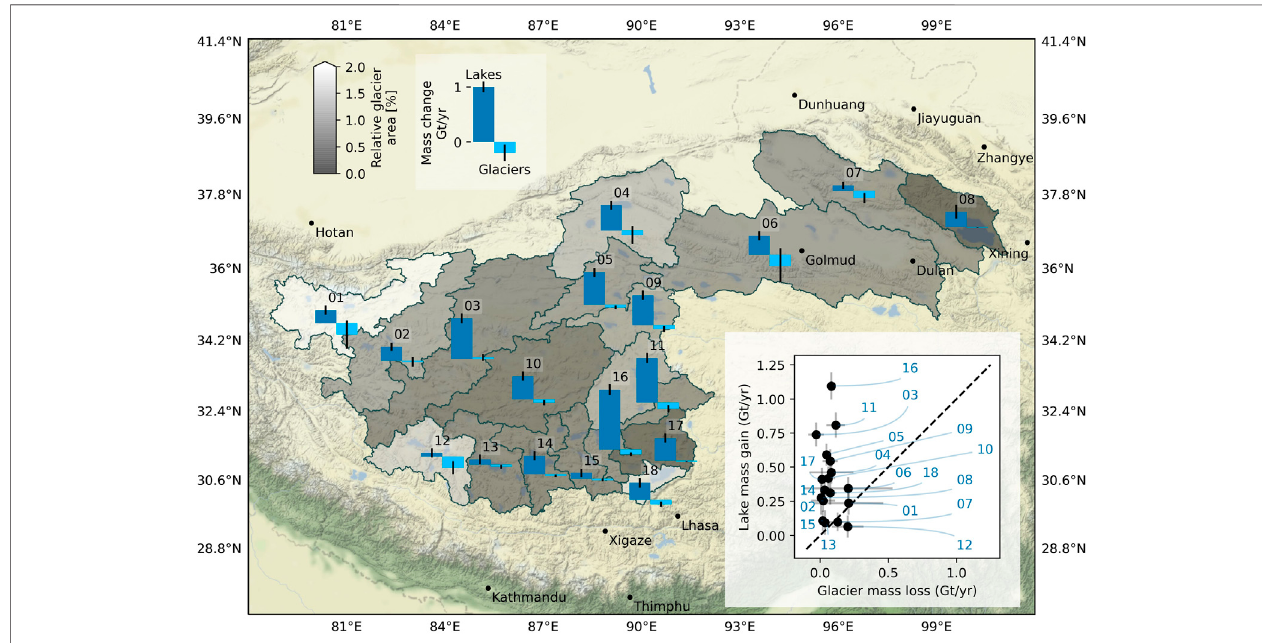
FIGURE1| Lakeandglaciermasschangeforthe18endorheicbasinsconsideredinthisstudy.Thebluebarsrepresentthetotalmasschangesandtheblacklines represent uncertainties, with all bars plotted using the same scale. The basins are shaded according to the ratio between the glacier area and the basin area. The basemap is aterrain layerfrom Stamen (http://maps.stamen.com).The insetshows thelake mass gainas afunction ofthe glacier mass loss for each basin (black dots), with basin number labels in blue.